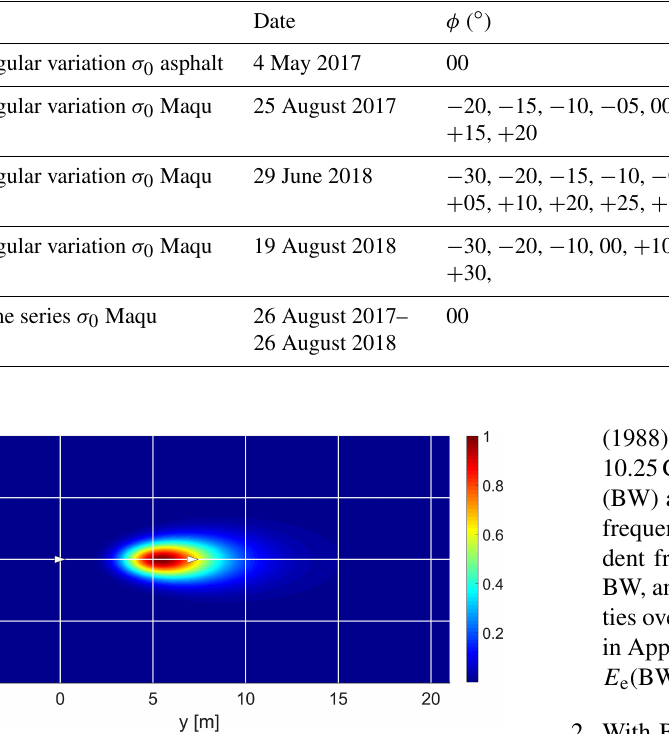
Figure 3. Example of G 2 /R 4 ( x,y ) with Gaussian antenna radia- tion patterns. Plot normalized to its peak value. x and y are ground surface coordinates. The white triangle at coordinate (0,0) repre- sents the tower location and the other white triangle indicates the intersection point of the antenna boresight line and the ground sur- face. α 0 = 55 ◦ , f = 5GHz and polarization is